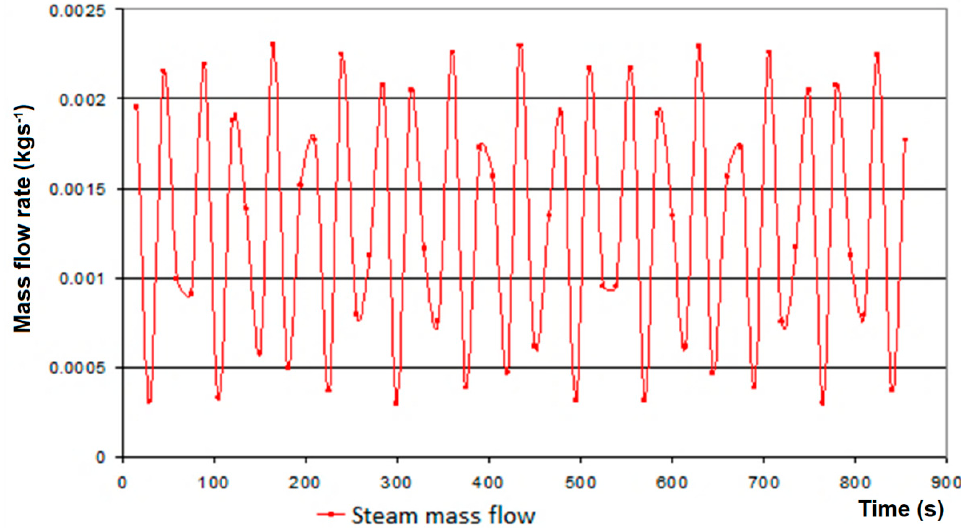
Figure 10. Steam supply into the gasification reactor.